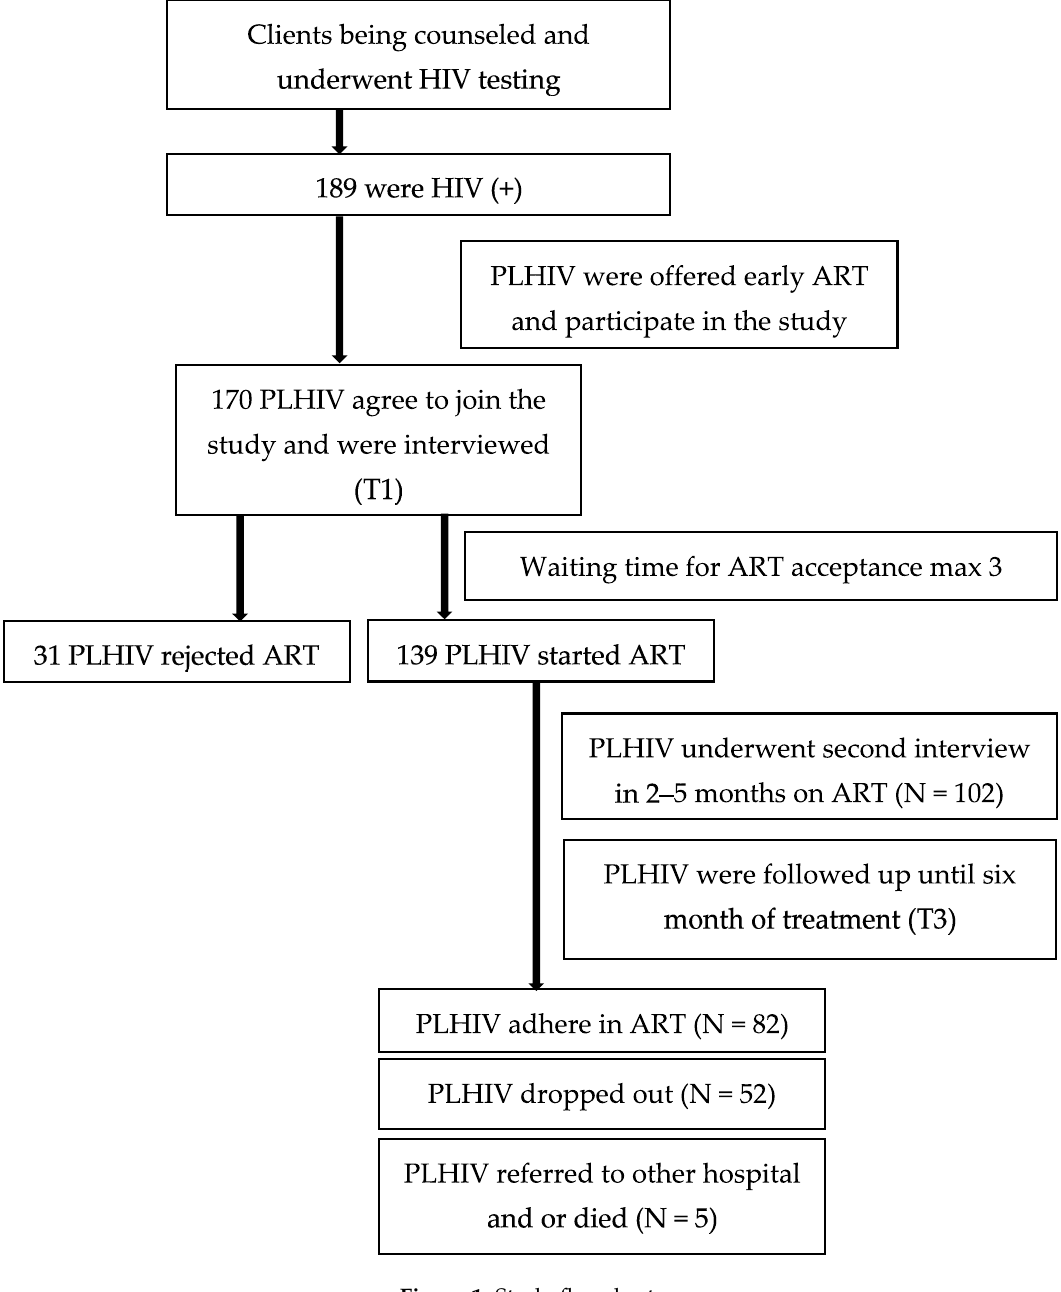
Figure 1. Study Figure 1. Study flowchart.